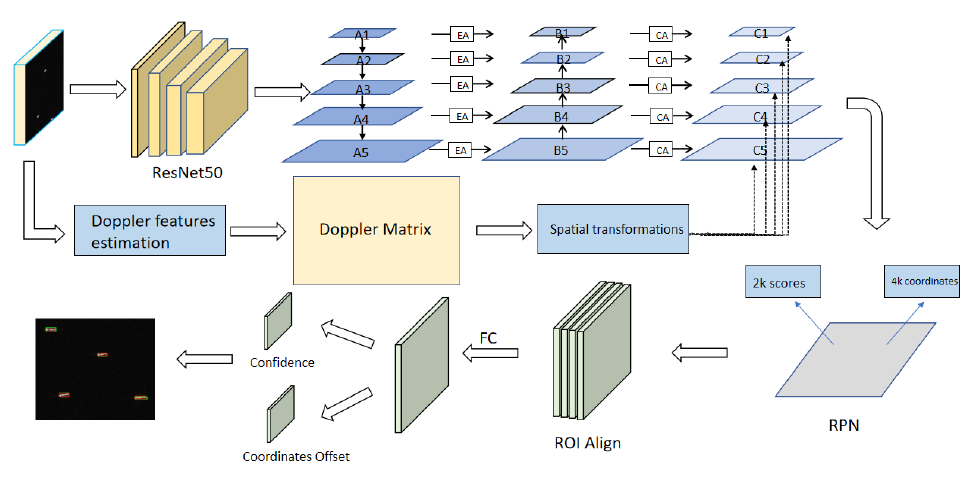
Figure 1. The architecture of the D-MFPN.